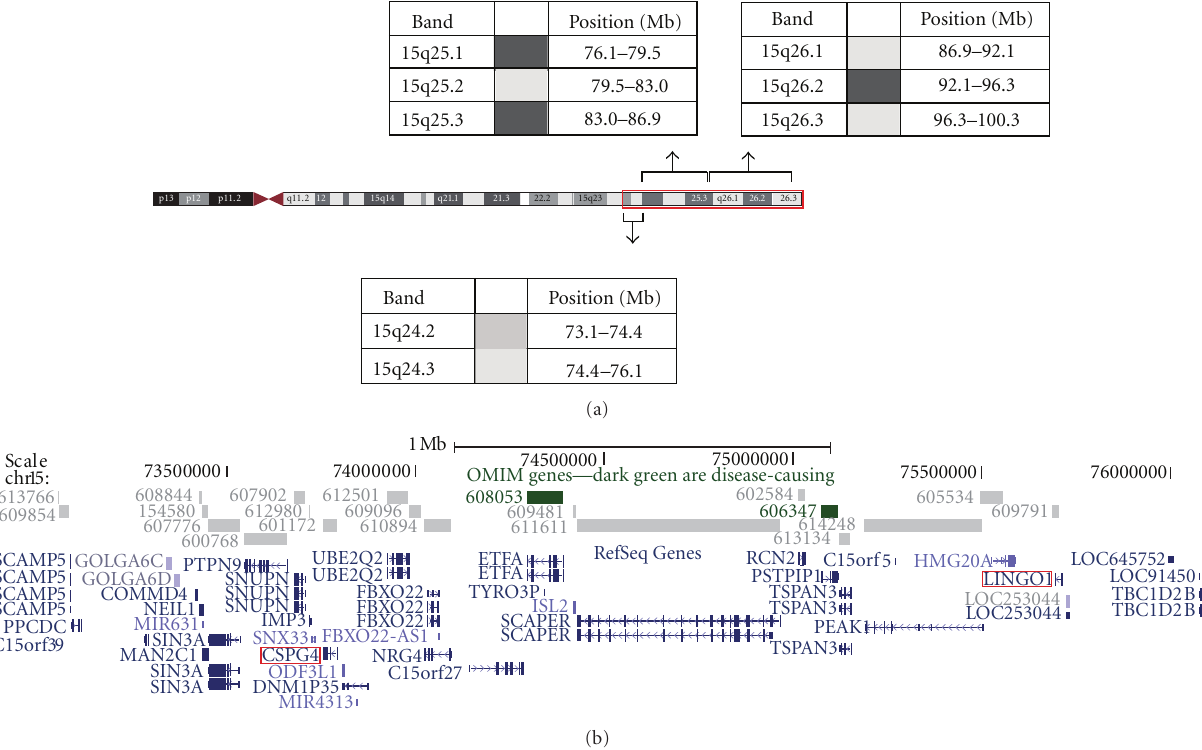
Figure 3: Schematic of the chromosome 15 region that shows increased dosage in the proband. (a) Shows an ideogram of chromosome 15, together with the location and extent of the duplication detected in the proband (15q24.2-qter; boxed in red); the base pair coordinates of the light and dark staining G-bands are also shown. (b) Shows the Refseq genes that are localised to 15q24.2-15q24.3; LINGO-1 and CSPG4 are shown in red boxes. These data and graphics were taken from the UCSC genome browser